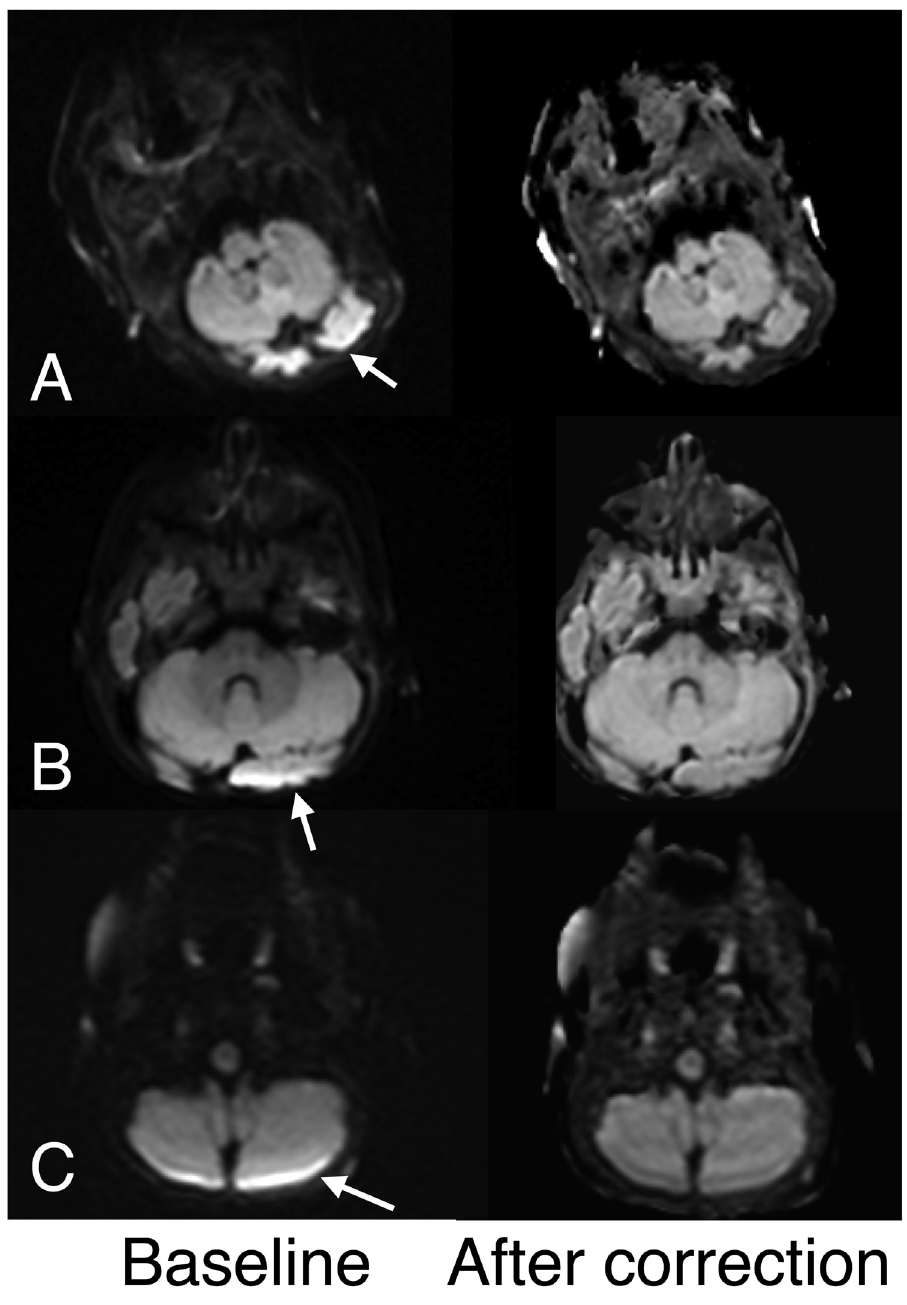
Fig 2. Examples of diffusion echoes before (baseline) and after intensity correction. A. Note that intensity variation (arrow) before correction is markedly improved after correction in this 7-day old female infant. B, C. Similar improvements are shown along the posterior fossae after intensity correction in a 4-month female infant (A) and a 17-month old male infant